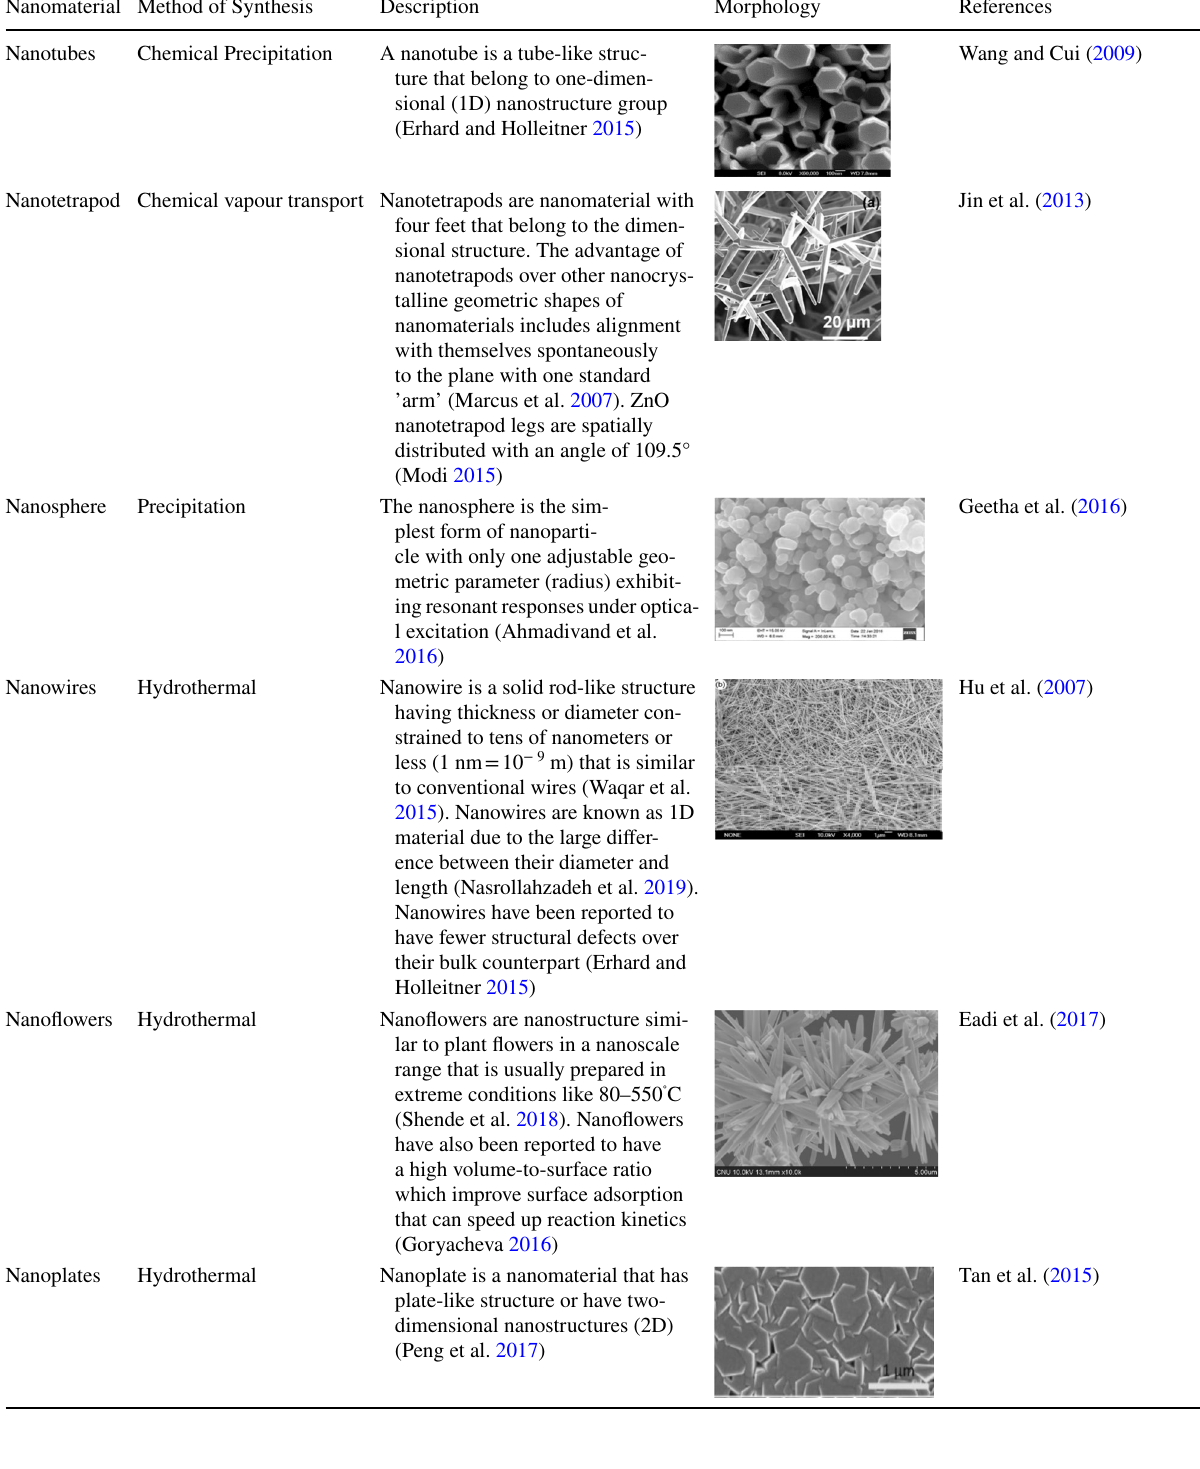
Table 2 Different morphology of zinc oxides methods and reaction conditions of ZnO nanoparticles Nanomaterial Method of